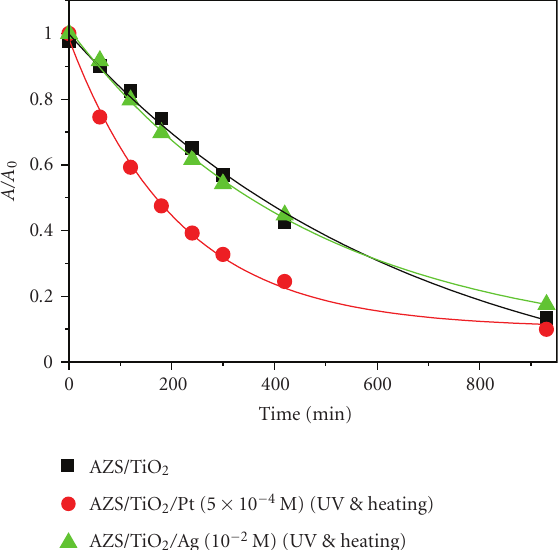
Figure 6: Comparative photodegradation curves of AZS with black light illumination in the presence of pure and modified TiO 2